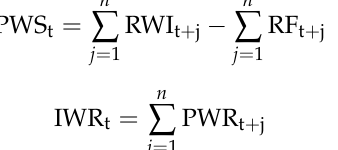
Growth stages Transplanting Ponding water depth